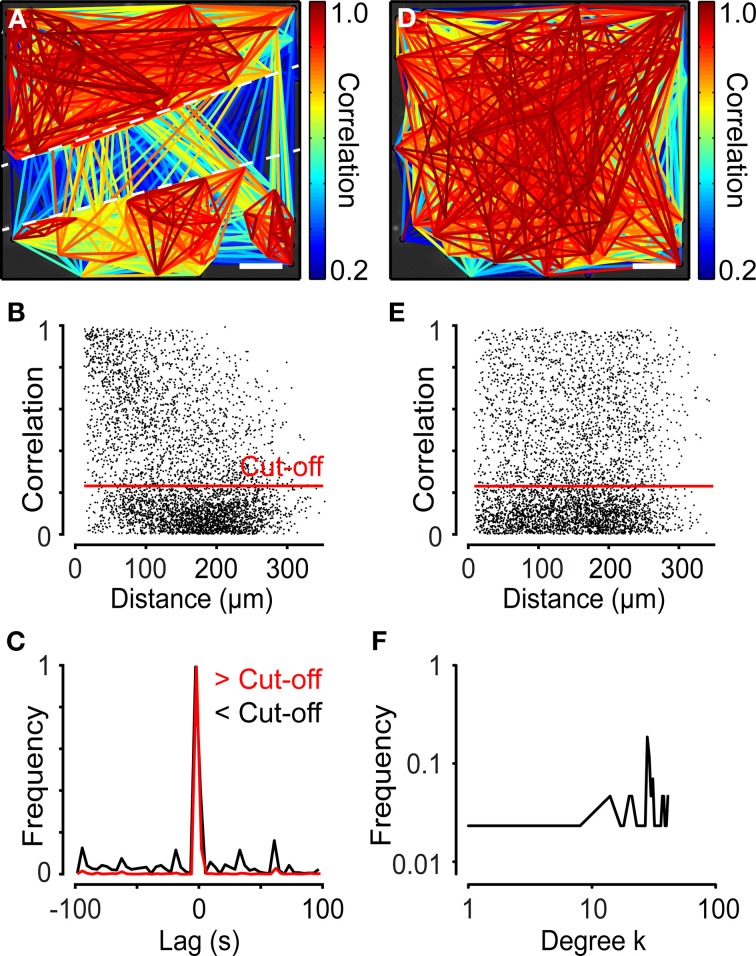
Network analyses performed on two separated cell ensembles in cardiac HL-1 cells. (A) Network of atrial HL-1 cells with a cut-off of 0.23, plotted on top of a microscope image. A cut divided the cells into two populations, as indicated in the figure. (B) Correlation as a function of distance for the experiment shown in (A). (C) Lag distribution for the maximum correlations above cut-off (>Cut-off), shown in red, and below cut-off (<Cut-off), shown in black. Note the small peaks for values below cut-off. (D) Network plot of data from (A) with x-y-coordinates of all cells randomized. (E) Correlation as a function of distance for the data shown in (D). (F) Degree distribution of the analysis of the HL-1 cells shown in (A). Scale bars, 50 μm.